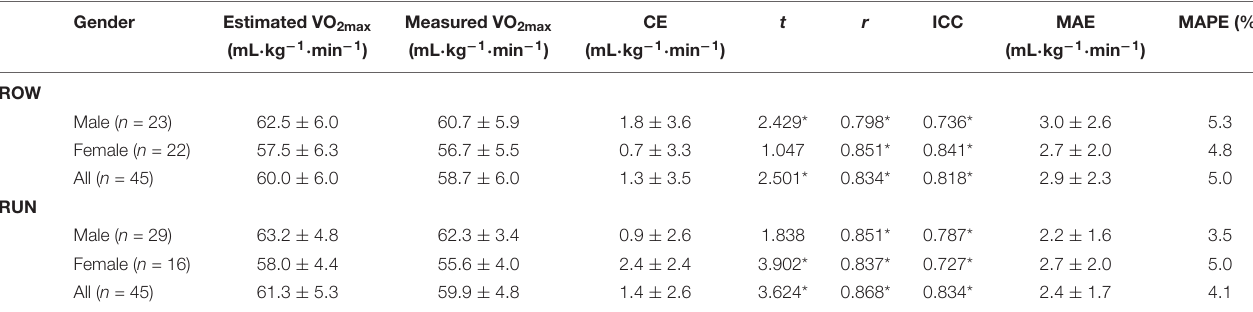
TABLE 3 | The correlations and differences between the estimated VO 2max from FFT and the measured VO 2max from GXT.